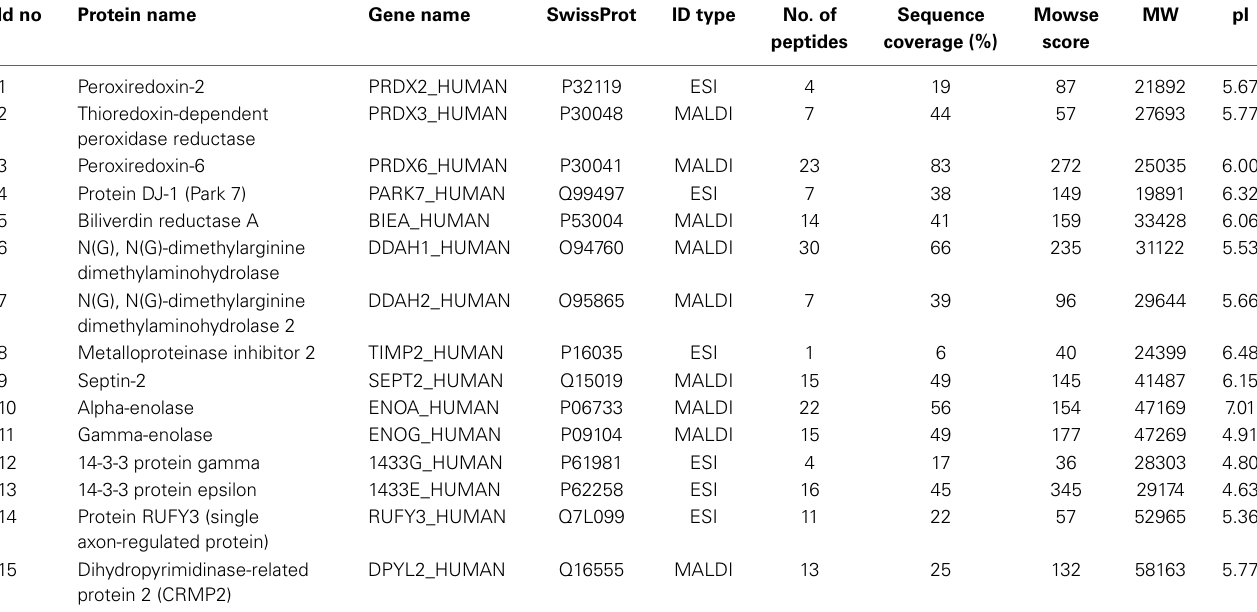
Table 3 | Proteins of human SH-SY5Y cells, identified with mass spectrometry and studied further with western